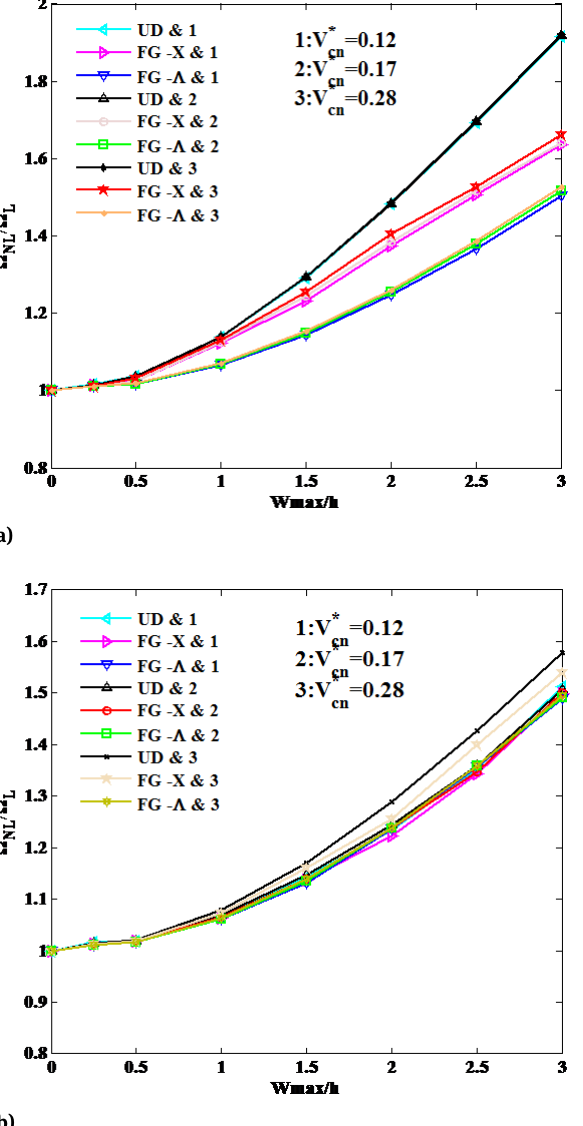
Figure 5: The temperature variation on the amplitude –frequency curves of three types of CNTRC beam without elastically supported foundation (a) and with elastically supported foundation (b) at a / h = 50, V * cn = 0.28 , T = 500 K, k 1 = 10 4 , k 2 = 10 2 , k 3 = 10 3 .